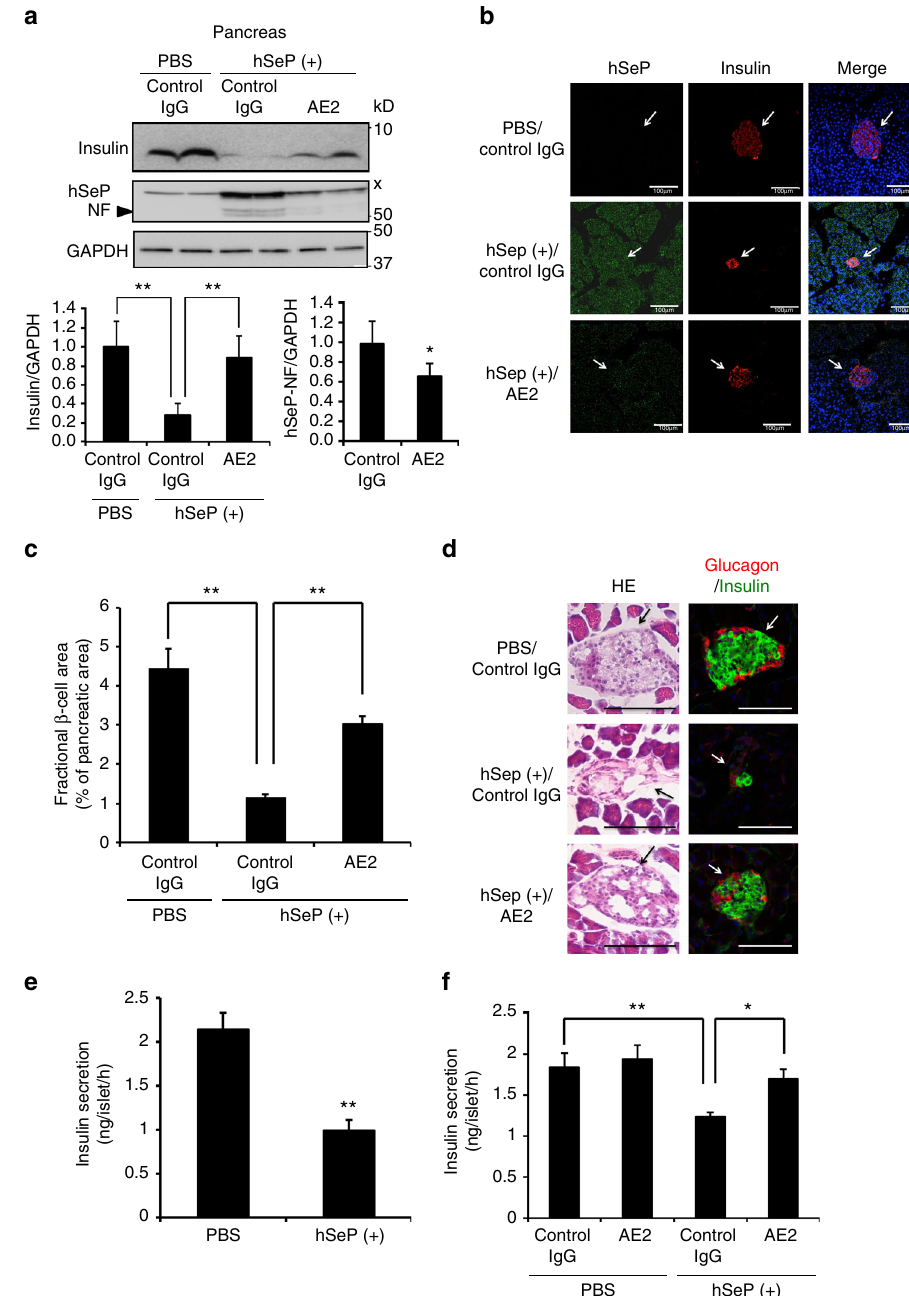
Fig. 4 The SeP-neutralizing Ab improved insulin secretion impaired by SeP. a SeP-neutralizing mAb AE2 improved pancreas insulin levels. After administration of AE2 and hSeP, pancreas tissues were homogenized and analysed by western blotting ( n = 5 – 8, means ± s.e.m.). Non-speci fi c bands are indicated by an x. ** P < 0.01, Tukey-ANOVA. * P < 0.05, Student's t -test. b , c Neutralizing mAb AE2 improved pancreatic β -cell area. Pancreas tissues from AE2- and hSeP-treated mice were examined immunohistochemically using anti-insulin Ab (indicative of β -cells) and anti-hSeP Ab b . Cell nuclei were stained with DAPI (blue). The distribution of hSeP in pancreatic β -cells was decreased in mice administered AE2. The proportion of β -cell area to total pancreatic area was determined ( c , n = 3, means ± s.e.m.). ** P < 0.01, Tukey-ANOVA. d Histochemical analysis of pancreas tissues from AE2- and hSeP- treated mice using haematoxylin and eosin stain (HE), anti-insulin Ab (green) and Glucagon (red, indicative of α -cells). Scale bars = 100 µ m ( b , d ). e Insulin secretion of isolated rat islets was signi fi cantly decreased by excess human SeP. Isolated rat islets were incubated with 10 µ g/mL hSeP for 24 h, and then insulin secretion induced by high glucose condition was evaluated, as described in the Methods ( n = 3, means ± s.d.). ** P < 0.01, Student's t -test. f Insulin secretion of isolated rat islets was signi fi cantly improved by AE2. Isolated rat islets were incubated with 10 µ g/mL hSeP in the presence of AE2 mAb or control IgG (500 µ g/mL) for 24 h, and then insulin secretion was evaluated ( n = 3, means ± s.d.). * P < 0.05, ** P < 0.01,